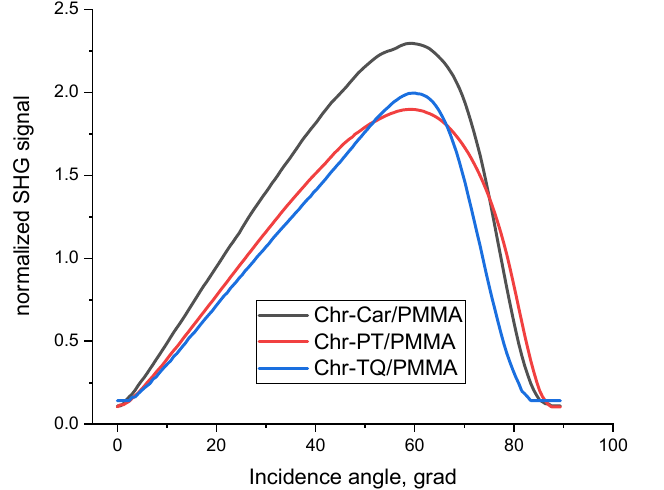
Figure 6. The dependences of the normalized SHG signal on the laser beam incidence angle for some polymer films.